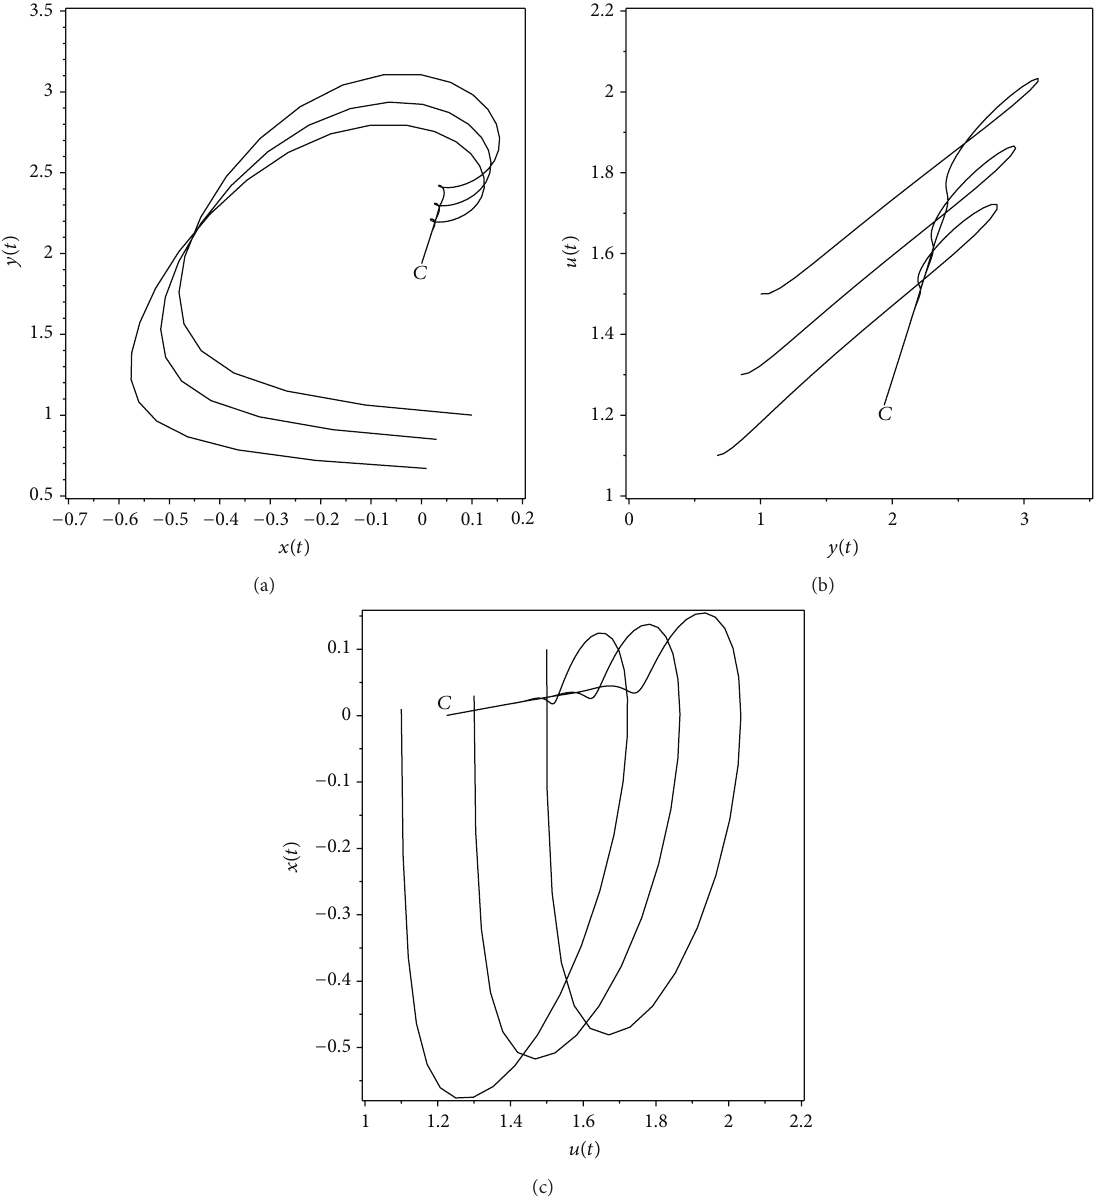
Figure 2: From (a) to (c), the projections of the phase-space trajectories on the 𝑦 − 𝑥 , 𝑢 − 𝑦 , and 𝑥 − 𝑢 planes with 𝜉 = 0.92 and 𝛼 = −1.5 . The trajectories are attracted by the point 𝐶